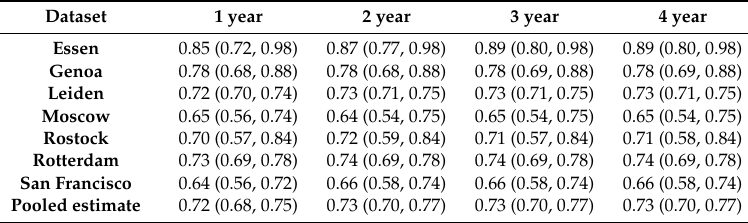
Table 2. Discrimination—per year up to 4 years of follow